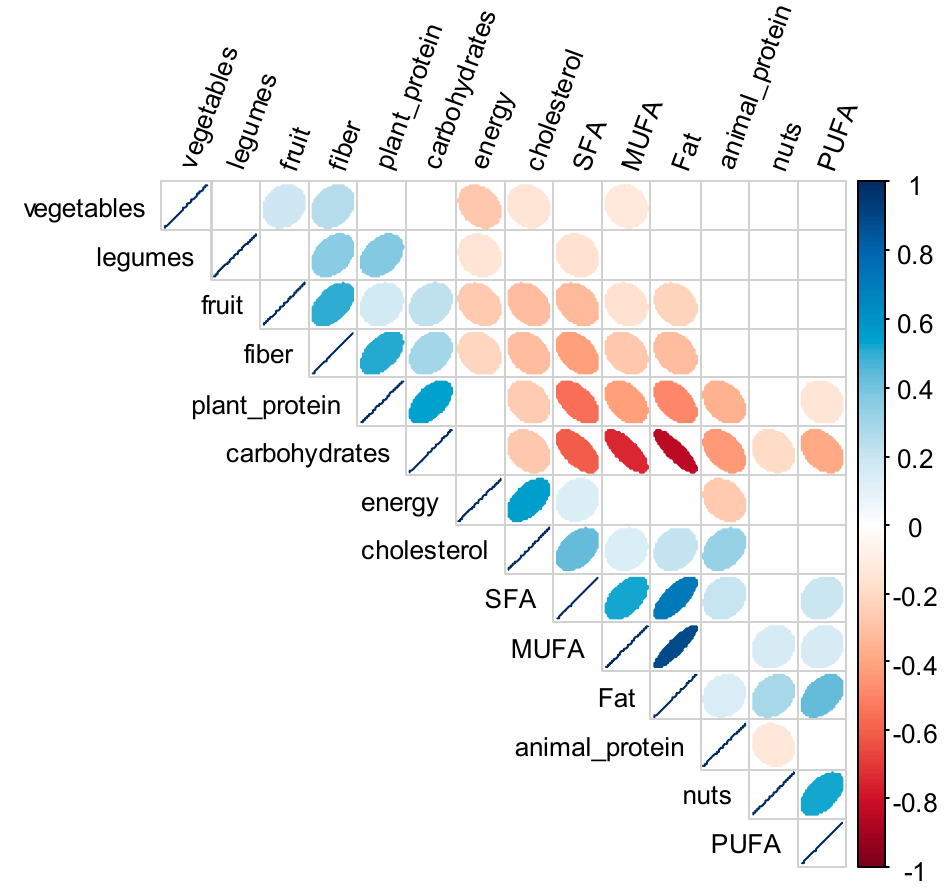
Figure 2. Correlogram of the upper triangular of the correlation matrix of the change in energy, nutrients, and food consumption (adjusted by energy) of 436 individuals from the CORDIOPREV (coronary diet intervention with olive oil and cardiovascular prevention) study after receiving dietary counselling. Figure shows correlations which p -values were <0.01. Positive correlations are displayed in blue and negative correlations in red, and colour intensity is proportional to the correlation coefficient. The ellipses have their eccentricity parametrically scaled to the correlation value. SFA: saturated fatty acids; MUFA: monounsaturated fatty acids; and PUFA: polyunsaturated fatty acids.